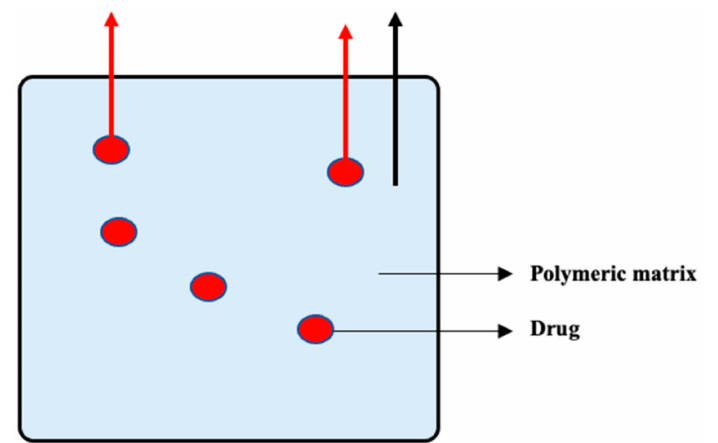
Figure 2. Drug diffusion through the polymeric matrix of a contact lens